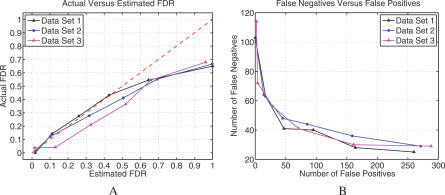
Actual versus Estimated FDR (A) and False Negatives versus False Positives (B)Results from using our model selection procedure and FDR estimation procedure on three datasets generated from a synthetic model learned on the real HIV data. There is a one-to-one correspondence between the points plotted in each figure.(A) Estimated and actual FDR. The dashed line denotes the idealized curve.(B) The number of false negatives (qij not recovered in these experiments, but appearing in the synthetic model), compared with the number of false positives (qij recovered in these experiments, but not in the synthetic model).